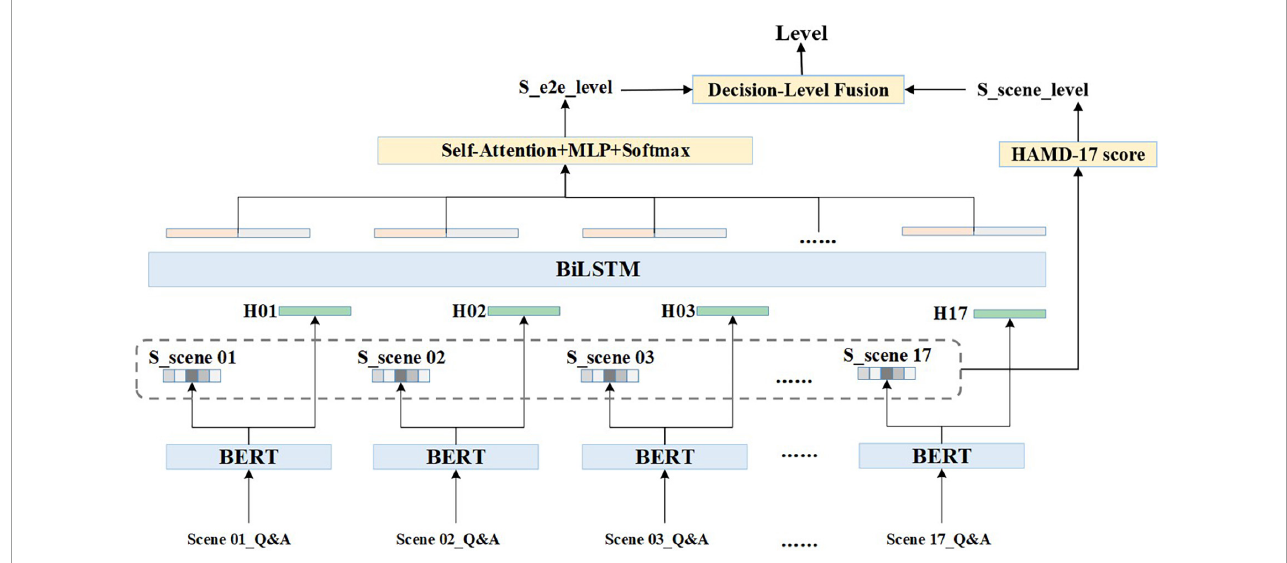
FIGURE1 General framework of multi-granularity and multi-task joint training (MGMT).